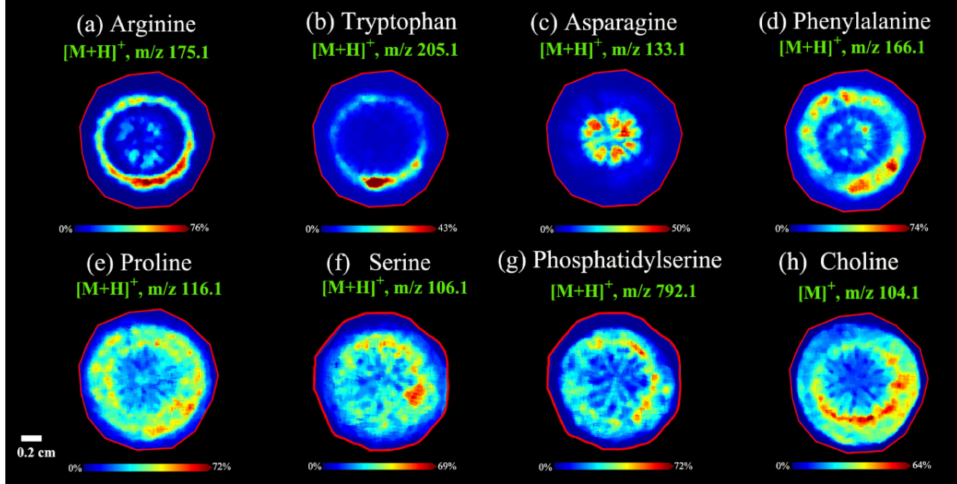
Figure 5. MALDI MS images of amino acids ( a – f ), phospholipids ( g ) and choline ( h ) in A. lappa roots. Data were collected from Baiji variety ( f , g ) and Yanagawa-riso variety ( a – e , h ) in negative ion reflector mode.